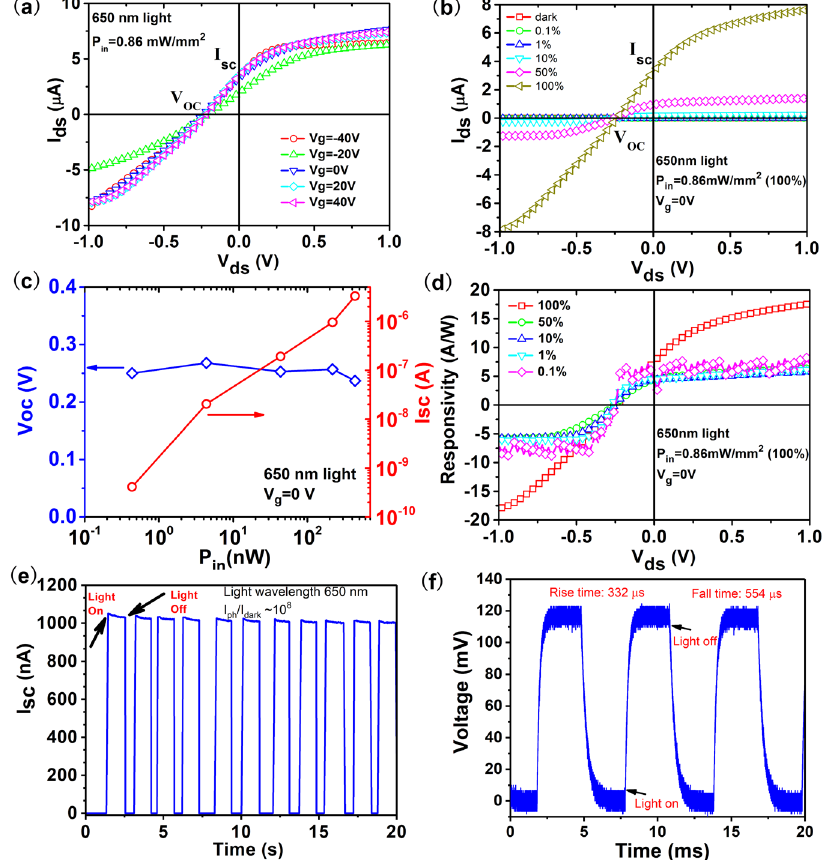
Fig. 3 Self-driven photoresponse of the photodetector. a Current – voltage ( I – V) characteristics of the graphene – WSe 2 – Au photodetector under different gate voltage bias. A 650-nm laser with the full power of 0.86 mW mm − 2 is used as the light source. b I – V characteristics of the graphene – WSe 2 – Au photodetector under varying light power densities and a zero gate voltage bias. c Dependence of I sc and open-circuit voltage ( V oc ) on the light power. d Dependence of the measured responsivity of the graphene – WSe 2 – Au photodetector on the light power density. e Dynamic I sc of the graphene – WSe 2 – Au photodetector under a zero gate voltage bias. f Fall time and rise time of the photodetector extracted from the dynamic voltage exerted to the serial